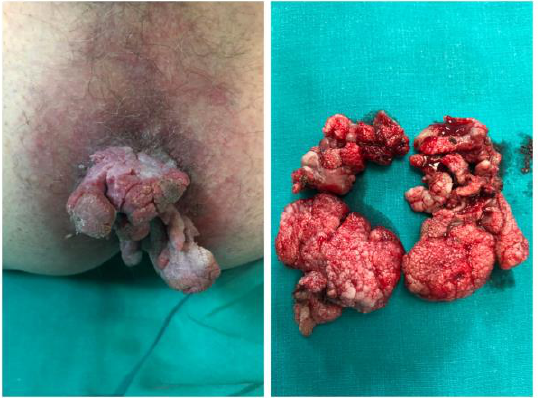
Figure 2. Clinical presentation of Giant CA (Bushke-Lowenstein tumor) and image of the specimen after excision.